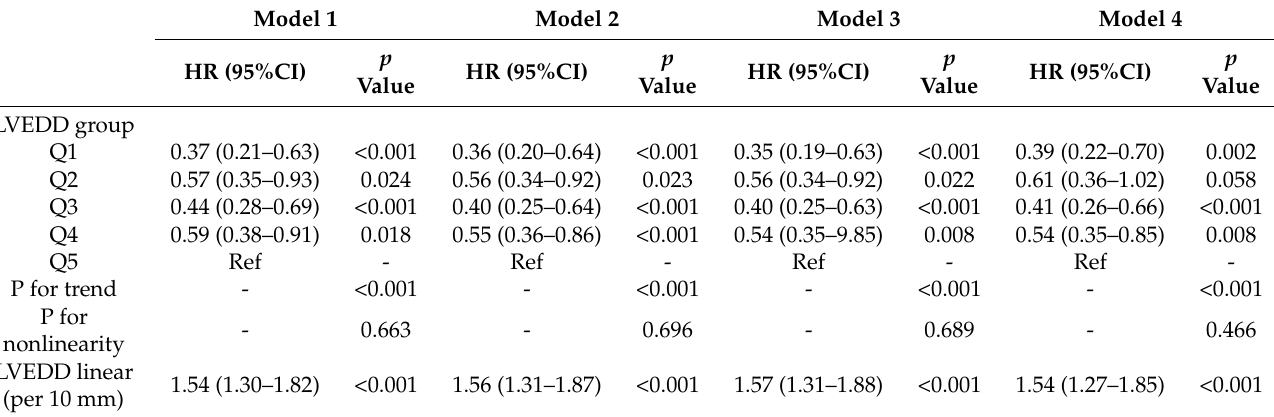
Table 3. Results of multivariable Cox regression for all-cause mortality by LVEDD